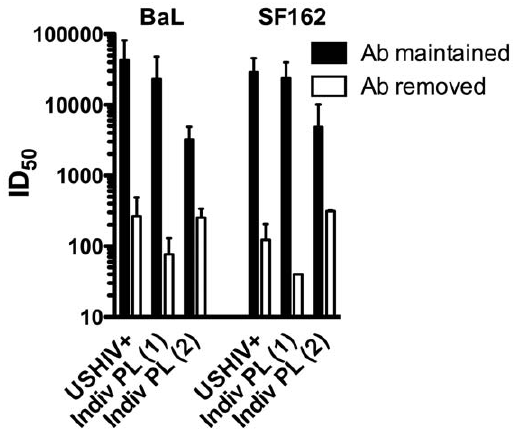
Figure 7. Higher neutralization is observed with antibody maintained in the assay. Using the 2 lucifease reporter IMCs (NL- LucR.T2A-SF162.ecto and NL-LucR.T2A-BaL.ecto), the ID 50 s for a serum pool (USHIV + ) and 2 individual plasmas are displayed for assay formats where the antibodies were maintained throughout the culture period (Ab maintained, black bars) or removed after infection (Ab removed, white bars). Each neutralization titer is an average of 2 experiments.